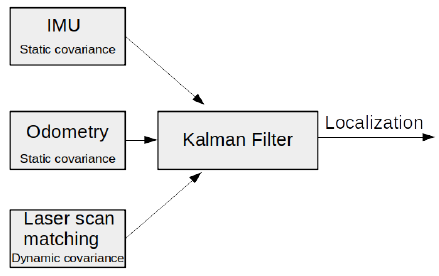
Figure 2. Schematic localization with odometric static